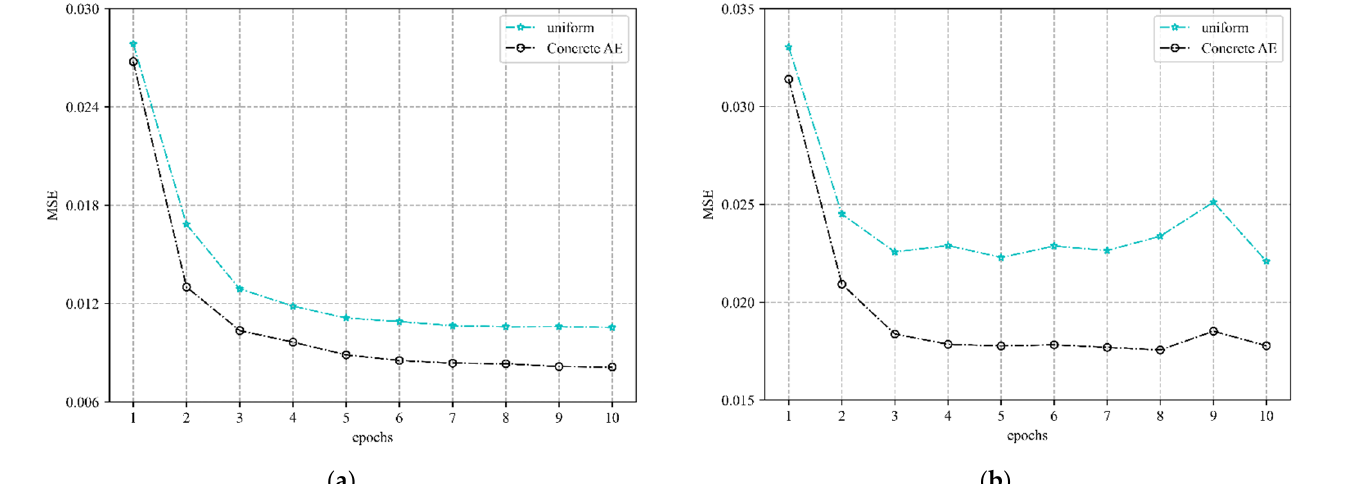
Figure 2. Performance comparison between uniform pilot design and concrete AE pilot optimization; ( a ) number of pilots = 16; ( b ) number of pilots = 8.